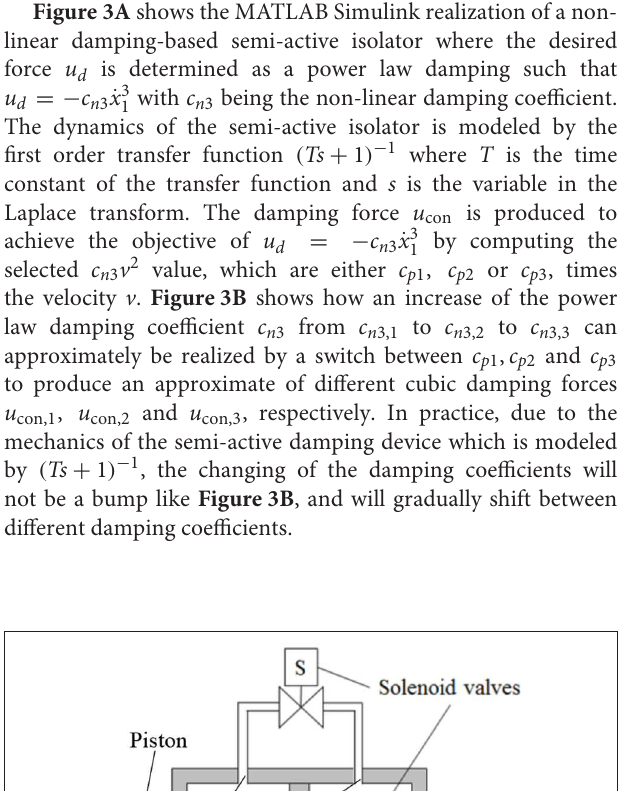
Frontiers in Built Environment |